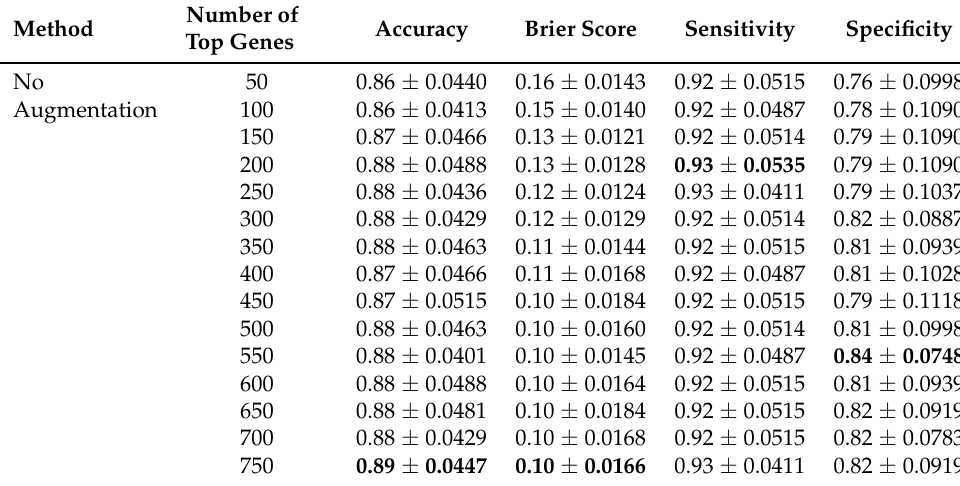
Figure 2. Results from 10-fold cross-validation in terms of accuracies ( A ) and Brier scores ( B ) for the microarray data when using different data augmentation methods and various numbers of top genes as input signatures. Error bars represent the 95% confidence interval of the mean. Table 1. Classification performance measures for microarray data (test subsets) after training with original training subset only. The table shows the 95% confidence intervals (mean ± 1.96 standard errors) for accuracy, Brier score, sensitivity and specificity, respectively. Values in bold are the best scores for the respective performance